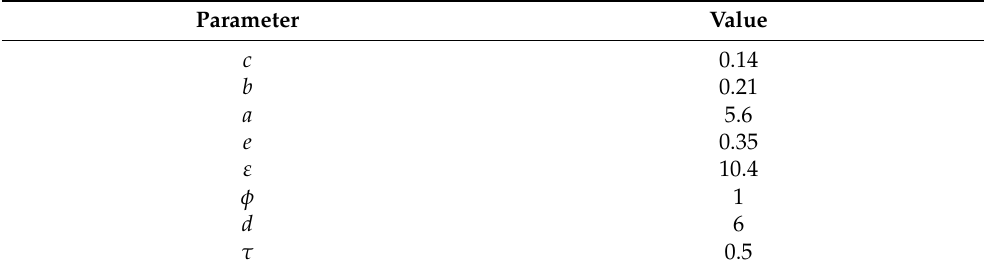
Table 2. The structural parameters of the three-dimensional FOGRN.